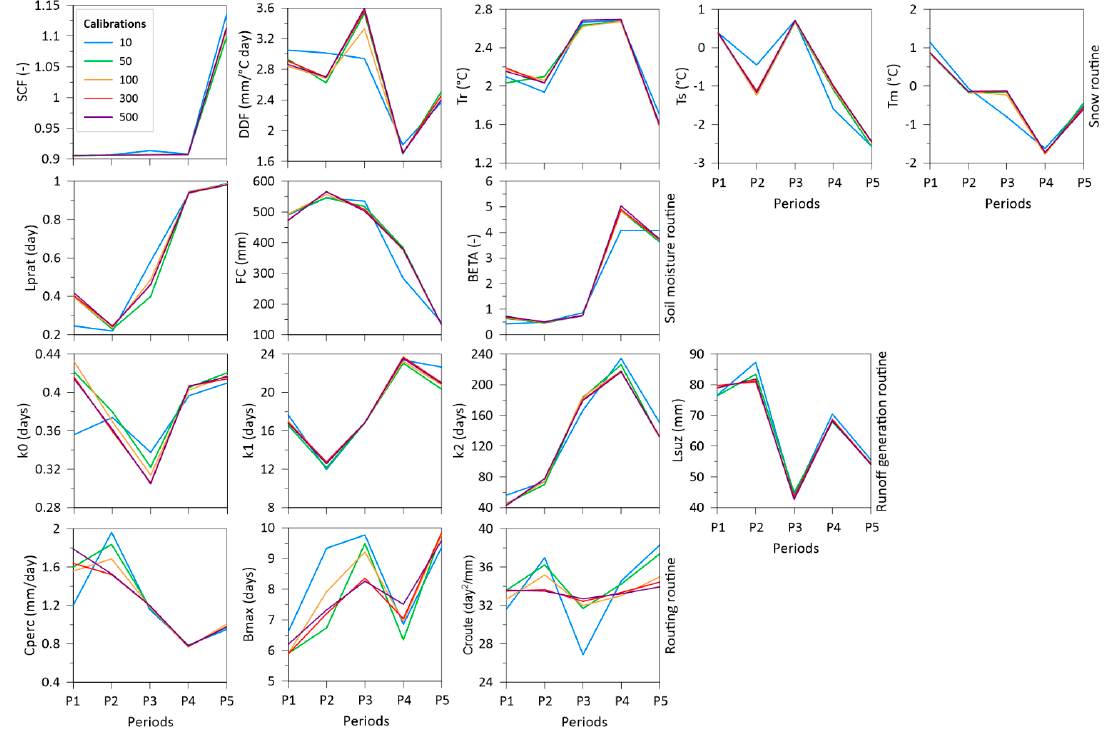
Figure 6. Medians of model parameters after 10, 50, 100, 300, 500 calibration repetitions in five specific periods.